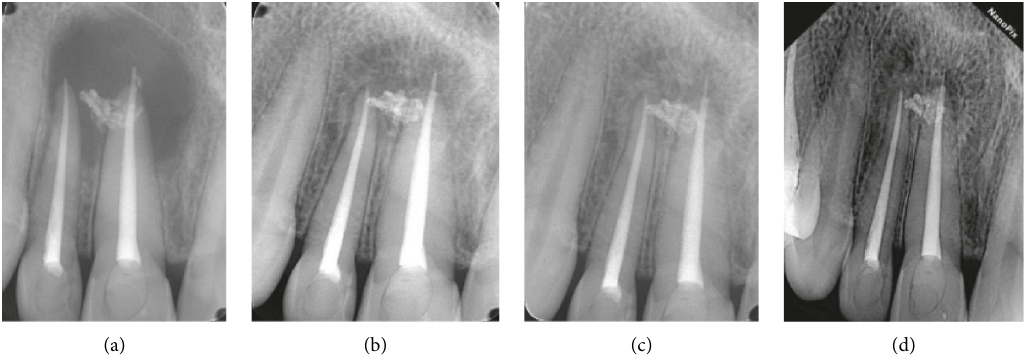
Figure 3: Large-size lesion in retreatment case. A: final obturation; B: 24 month follow-up; C: 36 month follow-up; D: 42 month